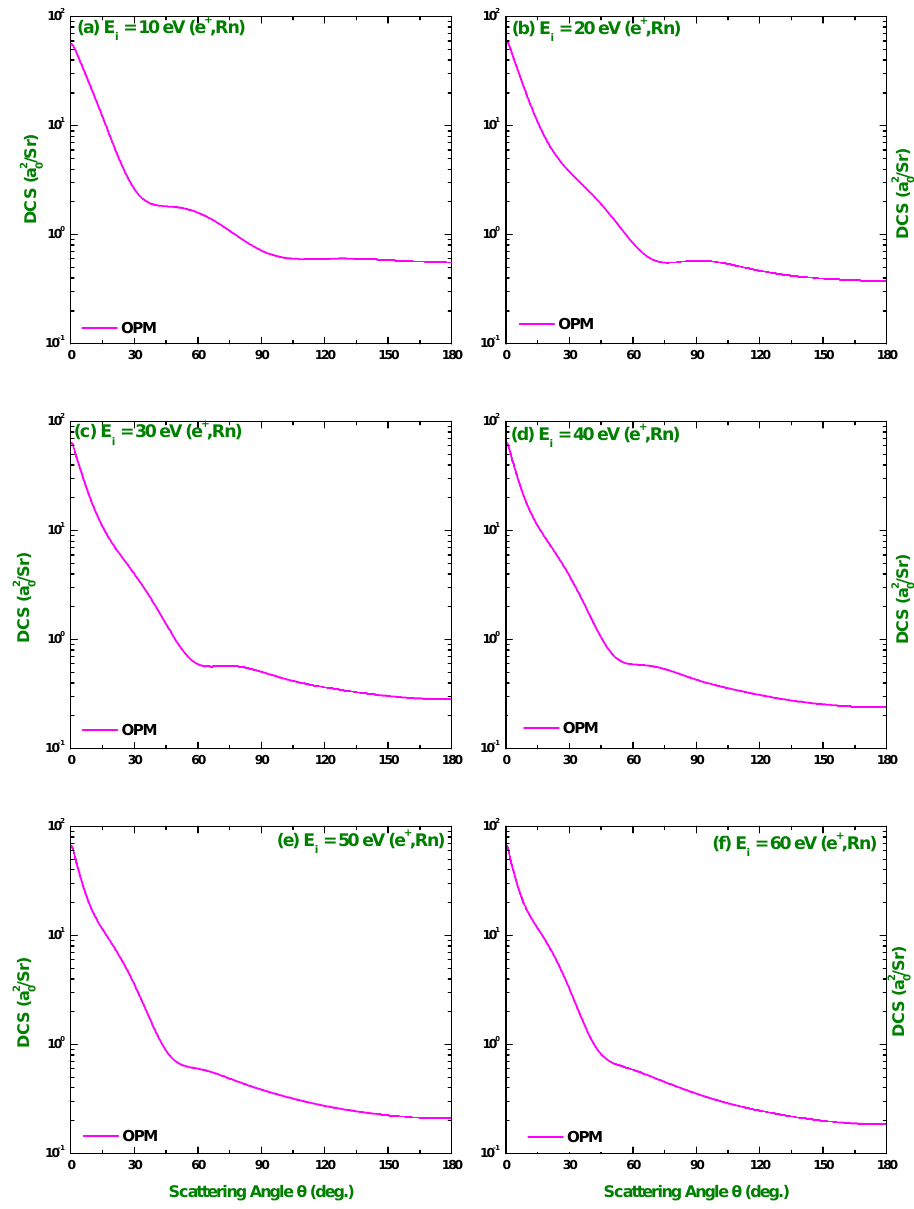
Figure 19. Differential cross sections for 10, 20, 30, 40, 50 and 60 eV positrons elastically scattered from neutral radon atoms as a function of scattering